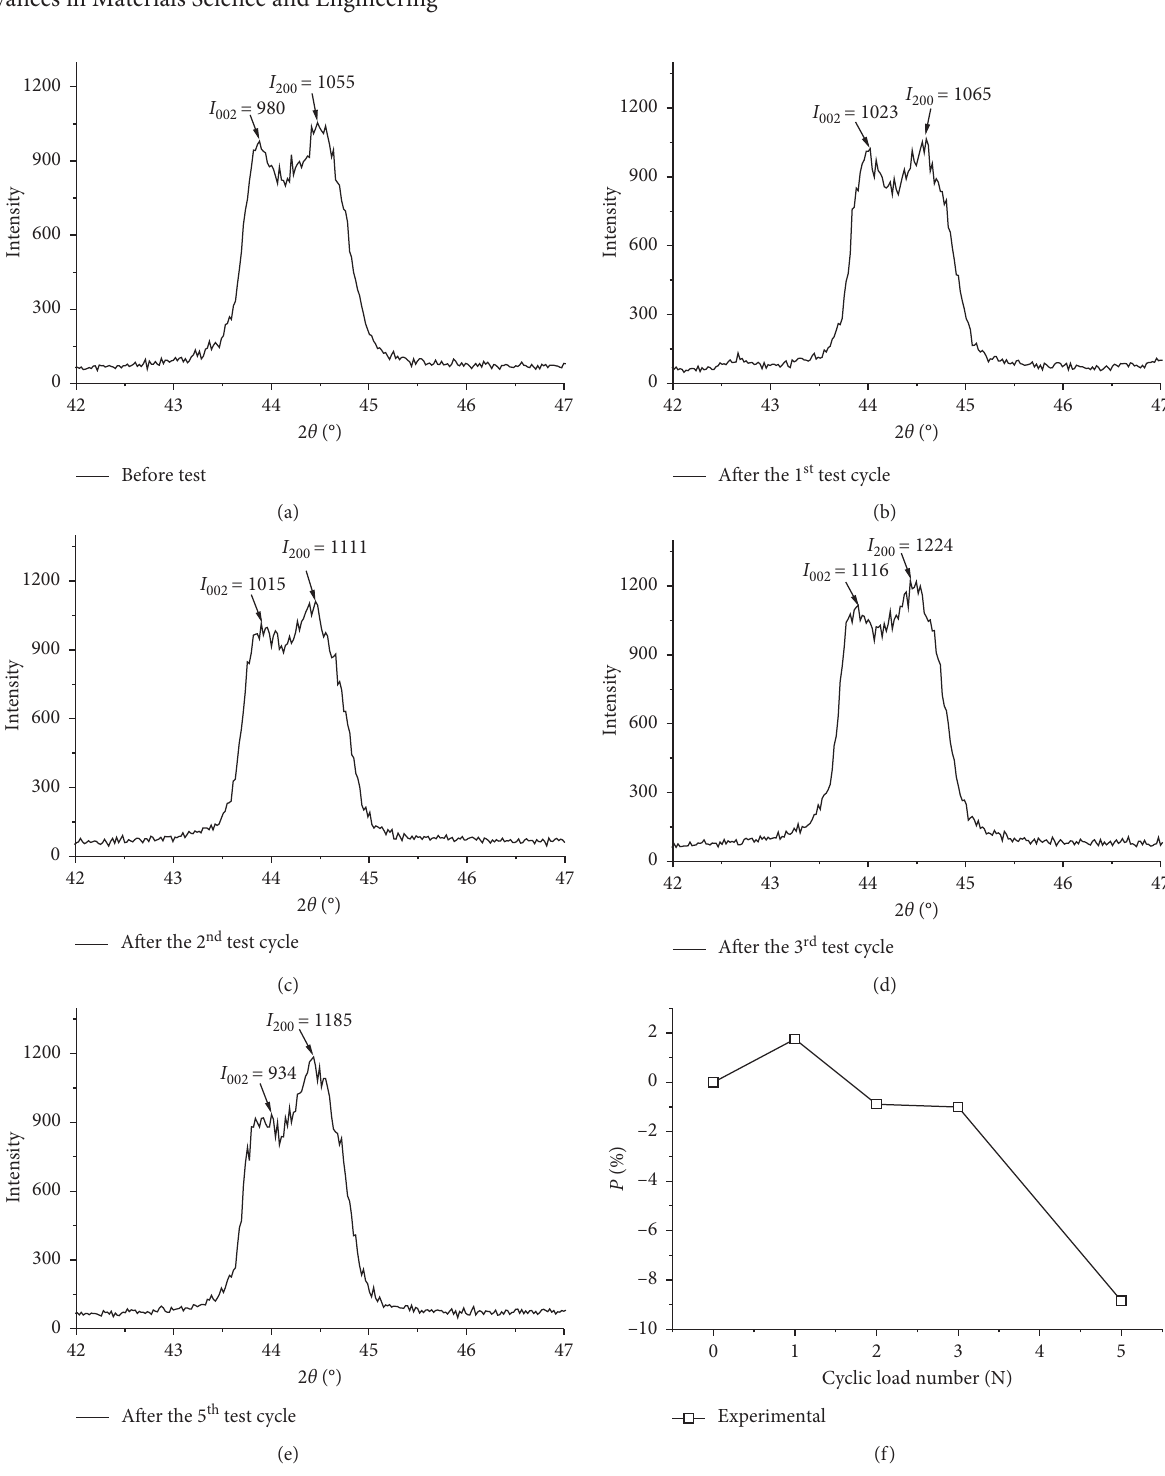
� 65MPa and d σ /d t � 1.0 MPa/s, 0